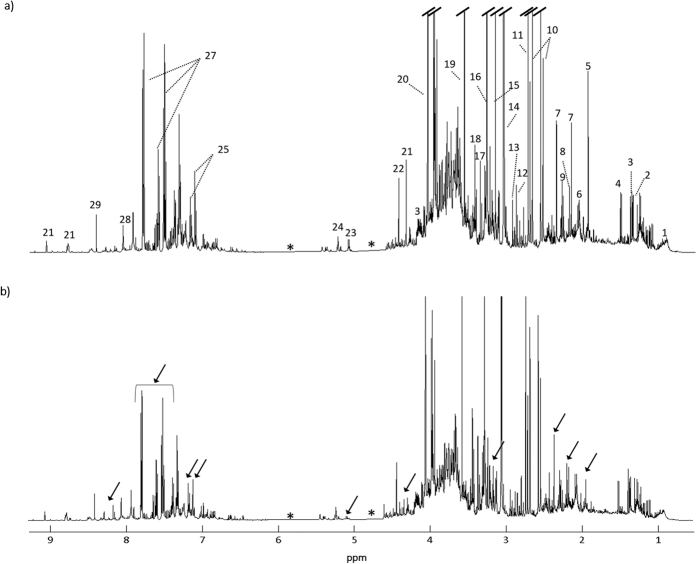
Average 1H NMR spectra of urine samples from (a) controls and (b) RCC patients. Legend: (1) isoleucine, (2) threonine, (3) lactate, (4) alanine, (5) acetate, (6) glutamate, (7) p-cresol sulfate (p-CS), (8) acetone, (9) valine, (10) citrate, (11) dimethylamine (DMA), (12) trimethylamine (TMA), (13) dimethylglycine (DMG), (14) creatine, (15) trimethylamine-N-oxide (TMAO), (16) 9-methyl-uric acid (tentative assignment), (17) methanol, (18) scyllo inositol, (19) glycine, (20) creatine, (21) trigonelline, (22) trigonellinamide, (23) unassigned (5.11 ppm), (24) glucose, (25) indoxyl sulfate (IS), (26) phenylacetylglutamine (PAG), (27) hippurate, (28) hypoxanthine, (29) formate. Arrows indicate visible spectral alterations. *Excluded regions (water and urea).